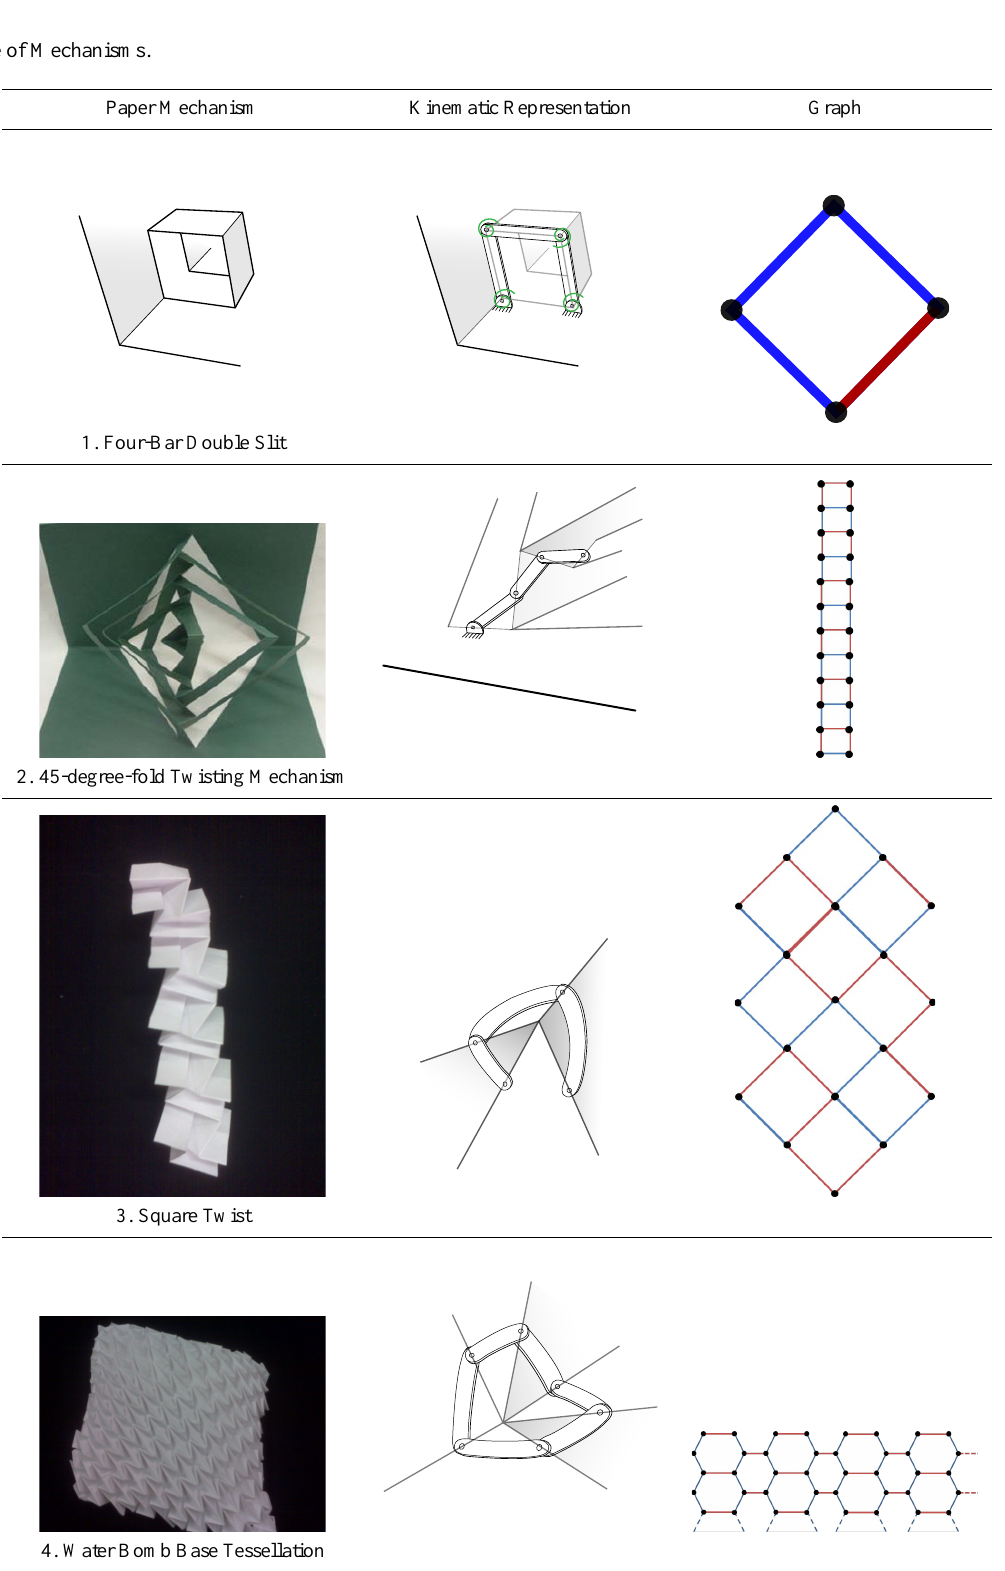
Table 2. Table of